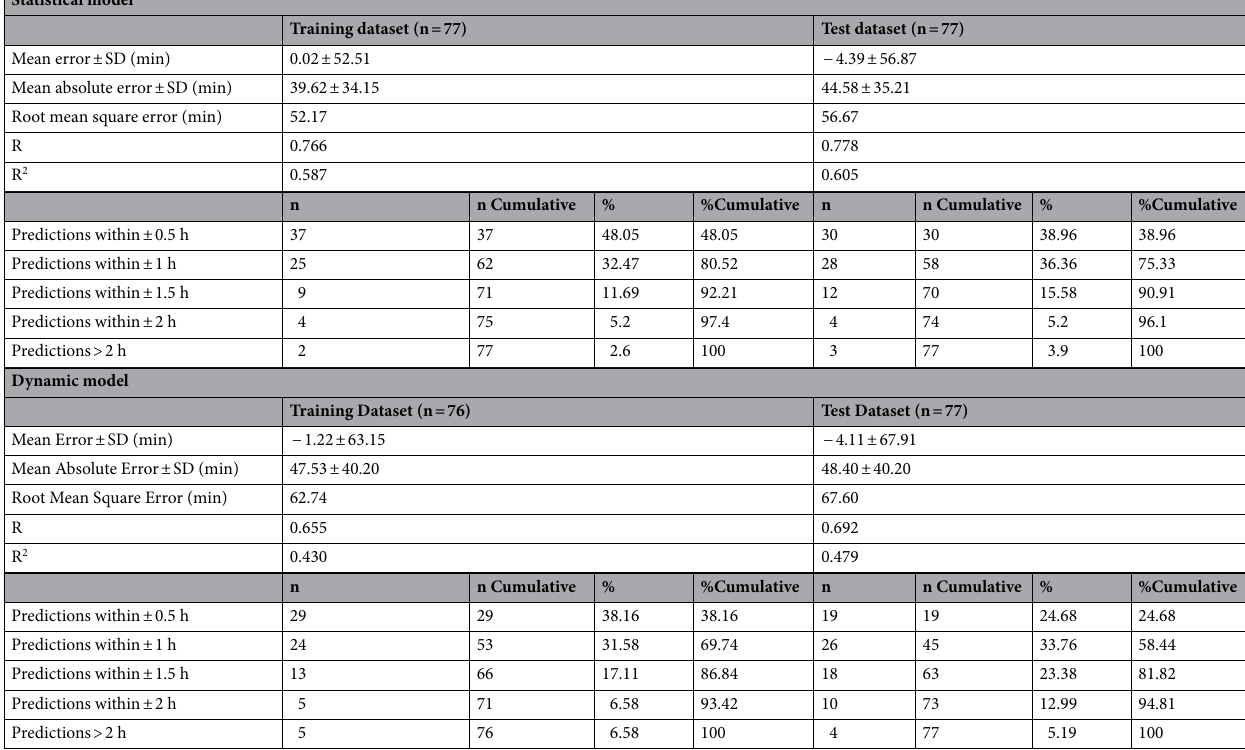
Table 2. Model summary with count and percent of predictions within ± 0.5 h, 1 h, 1.5 h, 2 h and greater than 2 h for the statistical and dynamic model training and tests